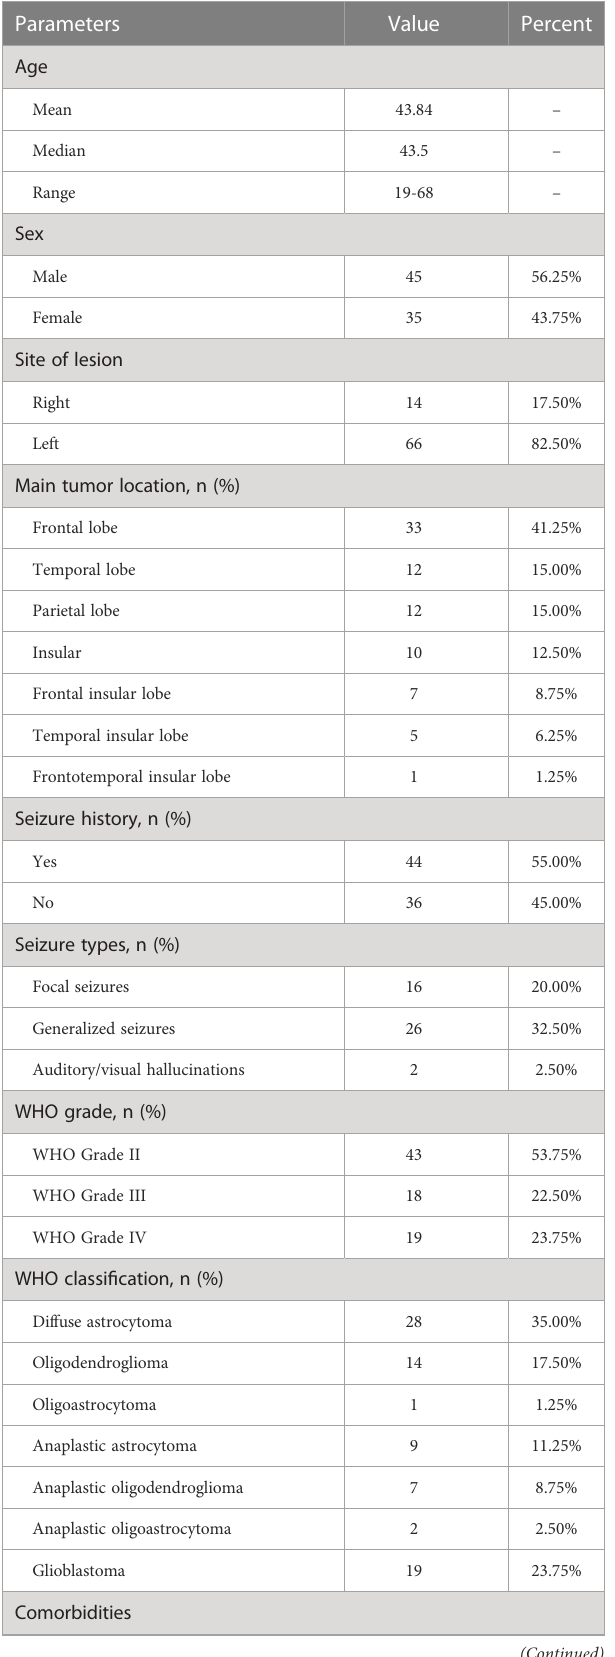
TABLE 1 Patient clinical characteristics and demographic